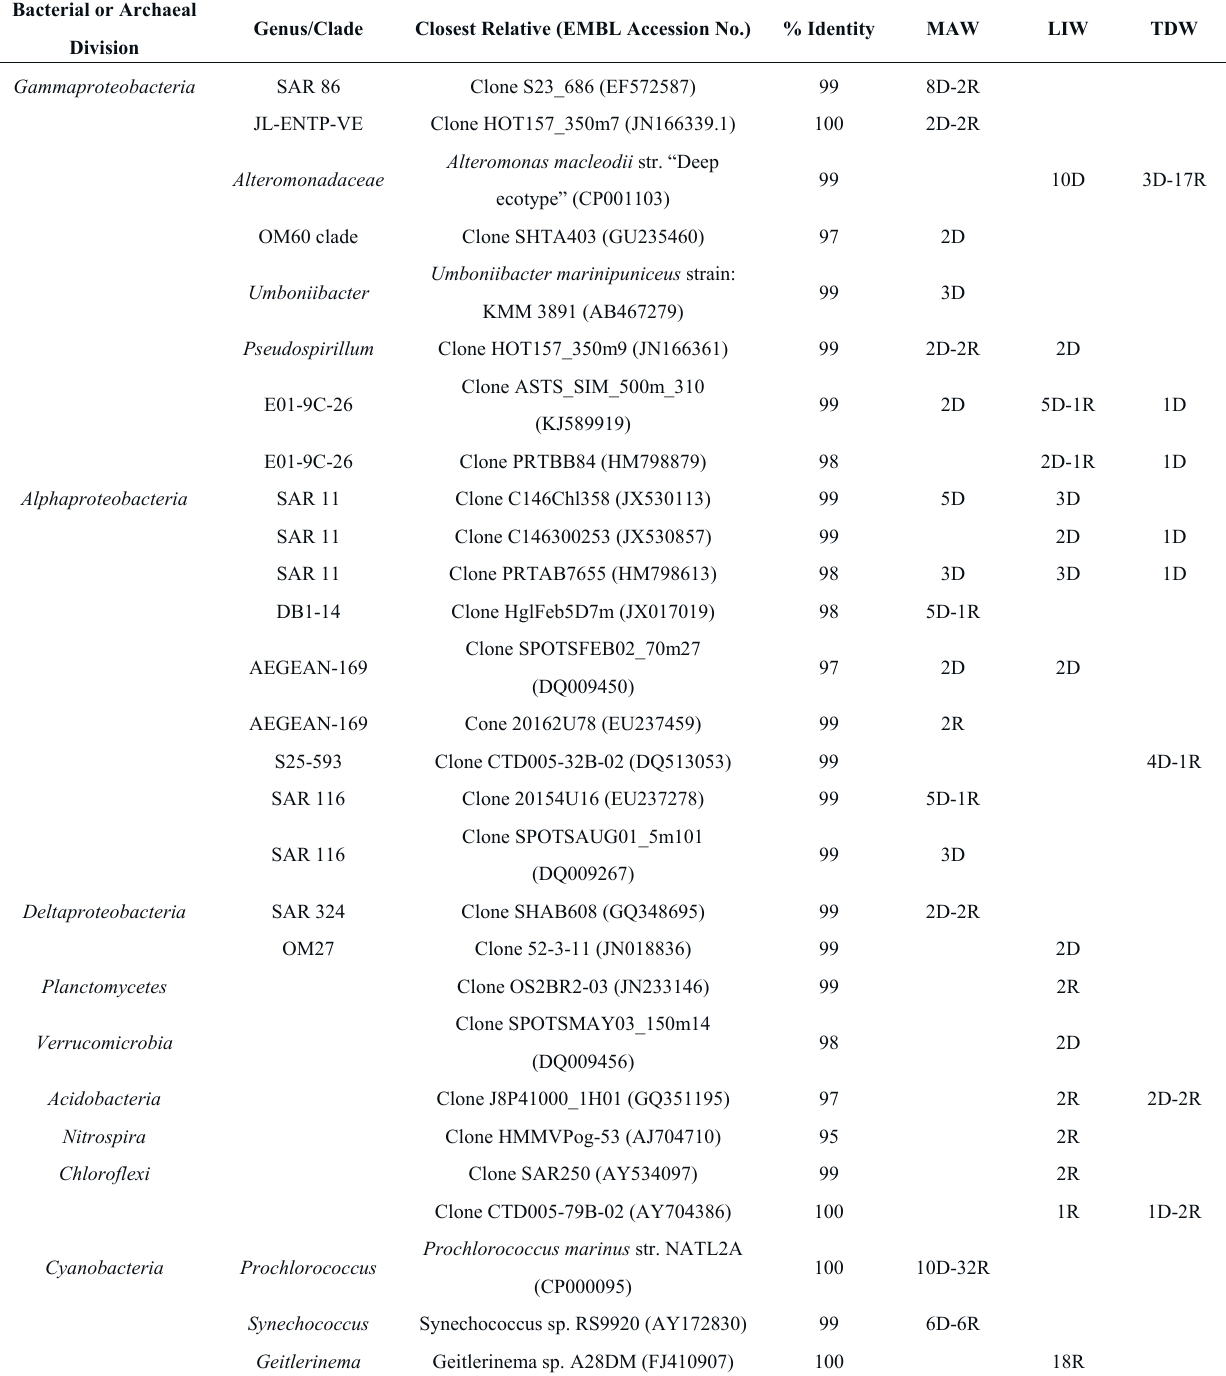
Table 2. Identification of representative phylogenetic groups obtained from clustering of rDNA and rRNA bacterial clone sequences from different depths (MAW = 25 m; LIW = 500 m; TDW = 3000